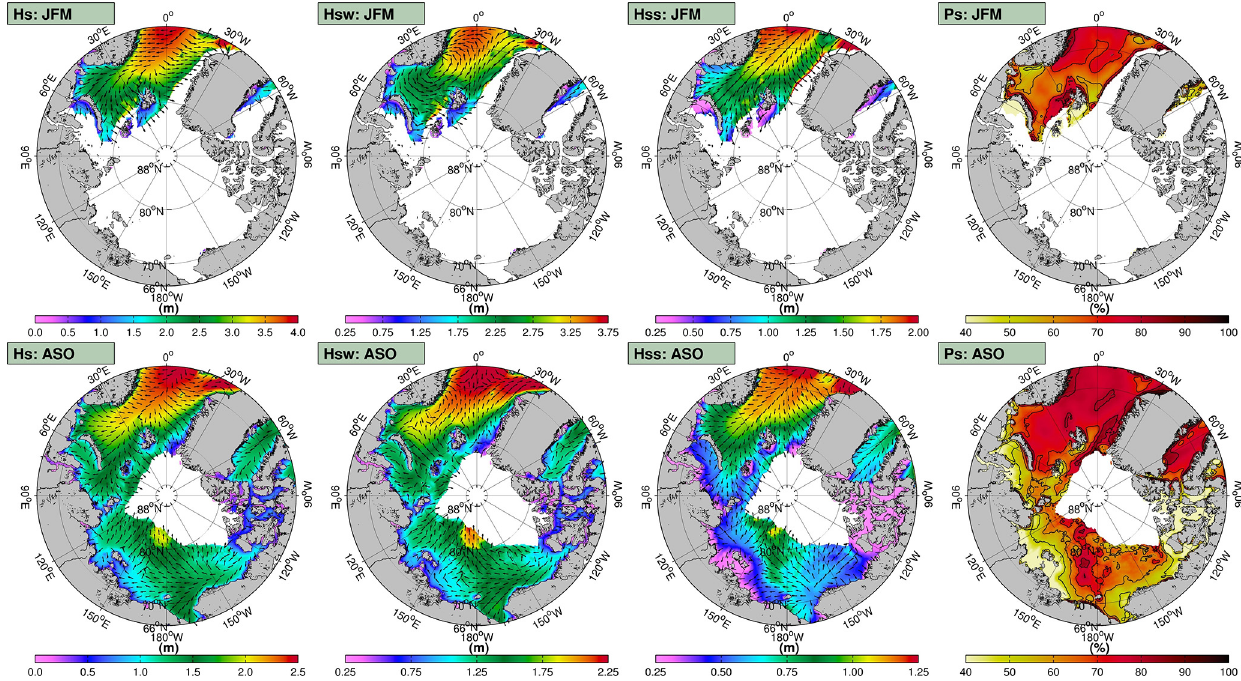
Figure 5. January–February–March (JFM) and August–September–October (ASO) seasonal averages of H s (first column), wind-sea wave height H sw (second column), swell wave height H ss (third column), and swell persistence P s (fourth column). The directions are computed from by averaging the east–west and north–south components